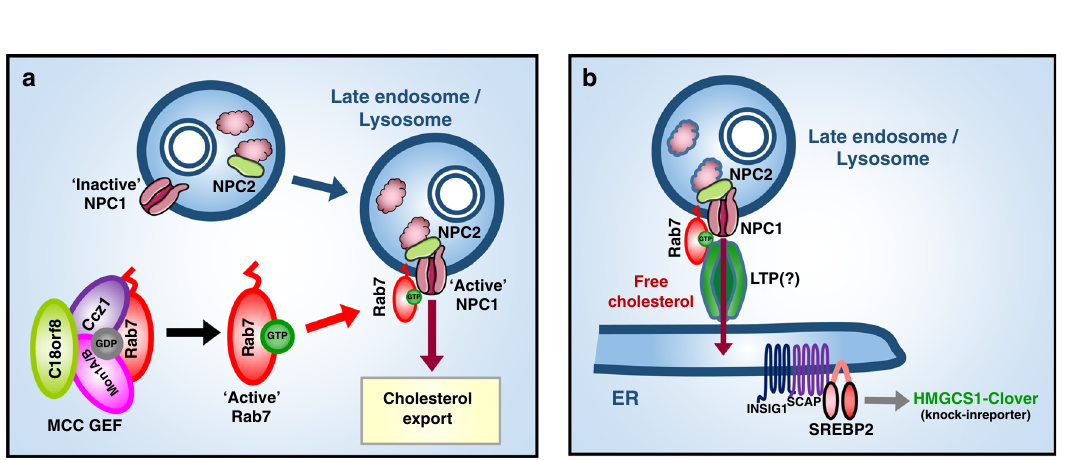
Fig. 9 Rab7 activation by the MCC GEF controls NPC1-dependent lysosomal cholesterol export. a – d Lysosomal cholesterol export is abolished in NPC1 -, C18orf8 -, Ccz1- and Mon1A/B -de fi cient cells. a Schematic depiction of the cholesterol export assay. Similar to a pulse-chase analysis, LDL-derived free cholesterol is allowed to accumulate in a lysosomal compartment using the NPC1 inhibitor U18666A (pulse) and released during the LPDS chase. b Free cholesterol (Filipin, green) accumulates in a CD63 + LE/Ly compartment (magenta) of wild-type HeLa cells following 24 h incubation with U18666A. c Wild-type, NPC1 -, C18orf8 -, Ccz1 - and Mon1A/B -de fi cient cells were treated for 24 h with U18666A (top panels), followed by a 24 h chase in the presence of LPDS and mevastatin (lower panels). Lysosomal cholesterol accumulation was visualised using Filipin (green) co-staining with the LE/Ly marker CD63 (magenta). d Co-localisation of Filipin with CD63 is plotted as Pearson correlation, calculated from n = 3 independent experiments with six fi elds per condition per experiment and >8 cells per fi eld. Error bars re fl ect standard error of mean (two-side paired t -test, ** p < 0.01, *** p < 0.001). e Cholesterol dominant-negative (T22N) or constitutively active Rab7 (Q67L) or empty vector and co-stained with Filipin (green) and anti-CD63 (magenta). broblasts. NPC1 I1061T/I1061T primary patient fi broblasts were transduced with a GFP-tagged wild-type Rab7 or vector control and analysed at day 7 for